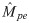
Data set M vs. v6M (or 10−2
D) and the model output M^pe for overall patients’ population.